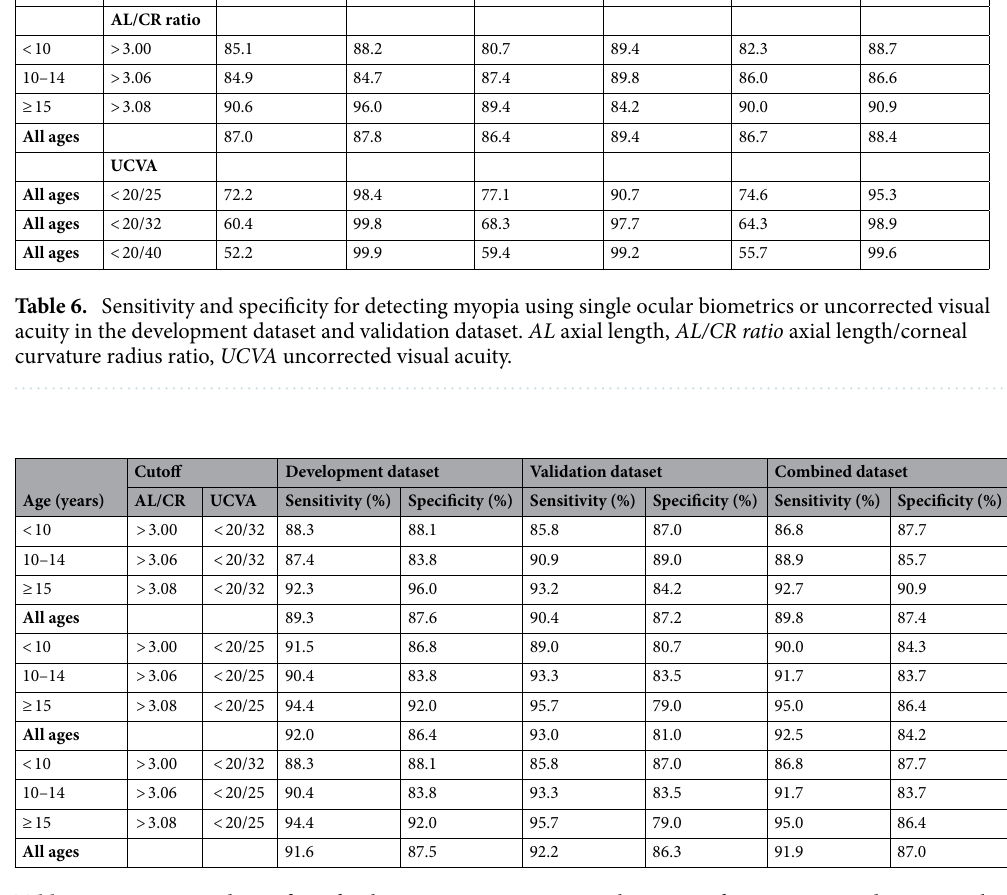
Table 7. Sensitivity and specificity for detecting myopia using combinations of AL/CR ratio and UCVA in the development dataset and validation dataset. AL axial length, AL/CR ratio axial length/corneal curvature radius ratio, UCVA uncorrected visual